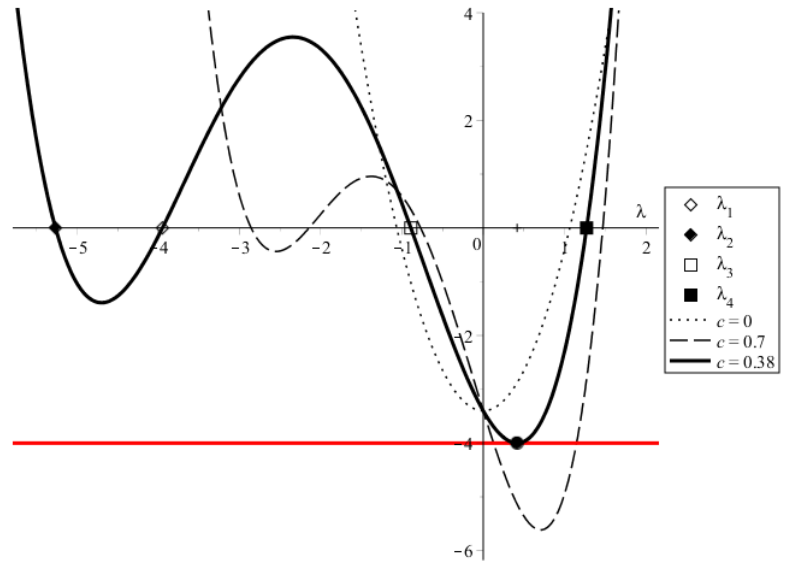
Figure A2. Solution of Equations (A2) and (A3). Black lines—LHSs, red line—RHSs. γ = 1.5, β = 2, = 10, and c values are σ = 1, D=1, R v = 1.2, N ρ